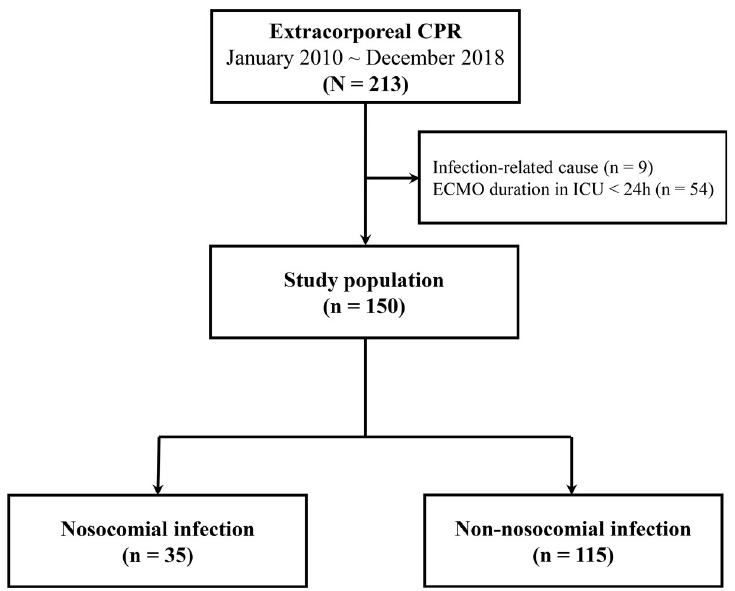
Fig 1. Study flow chart. CPR = cardiopulmonary resuscitation, ECMO = extracorporeal membrane oxygenation, ICU = intensive care unit.